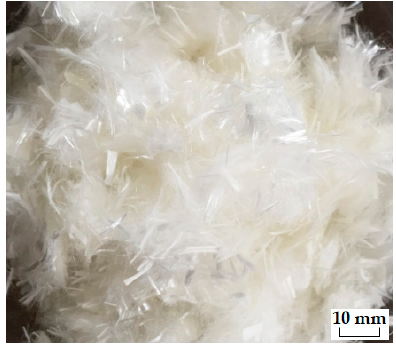
Figure 2. The PVA fibers used in this investigation.